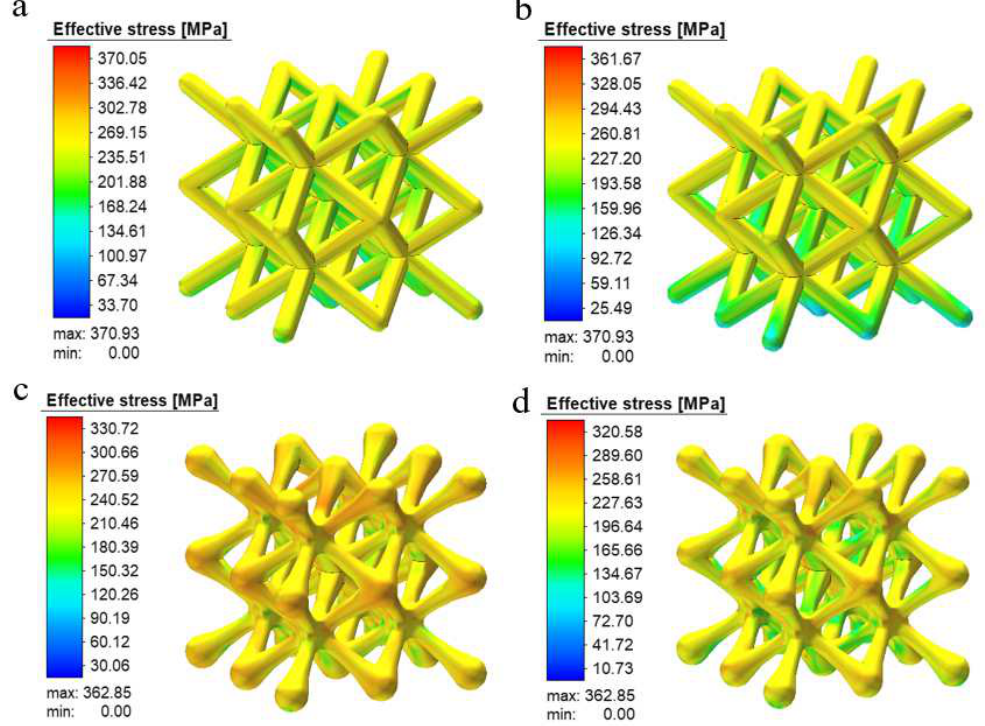
Figure 10. Cloud diagram of scaffold forming stress: ( a ) Before conventional structural base plate removal, ( b ) after conventional structural base plate removal, ( c ) optimization of the structure before cutting the base plate, and ( d ) optimization of the structure after cutting the base plate.